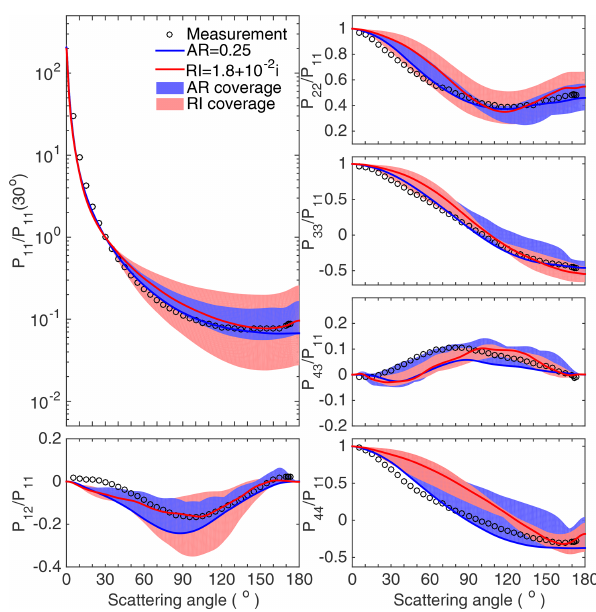
Figure 10. Similar to Fig. 9 but for the red clay sample. Figure 11. Similar to Figs. 9 and 10 but for the feldspar